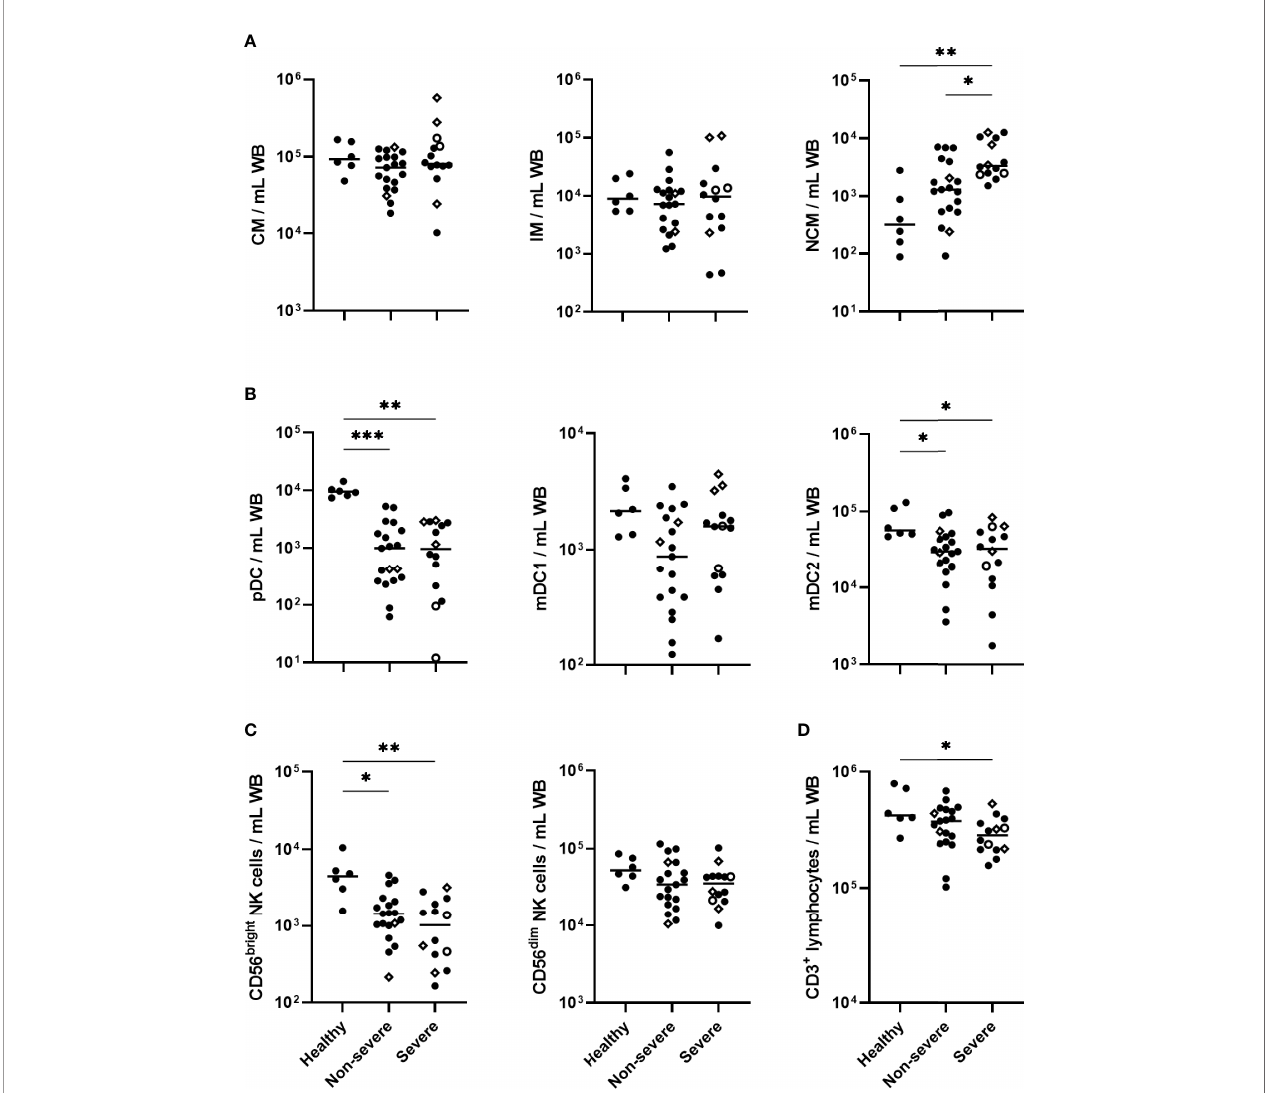
FIGURE 1 | Absolute cell numbers of monocytes, dendritic cell (DC) subsets, NK cell subsets and CD3 + lymphocytes in COVID-19 patients compared to healthy controls. Absolute numbers of (A) classical monocytes (CM), intermediate monocytes (IM) and non-classical monocytes (NCM); (B) plasmacytoid DC (pDC), myeloid DC1 (mDC1) and myeloid DC2 (mDC2); (C) CD56 bright and CD56 dim NK cells (D) CD3 + lymphocytes, are represented for healthy controls (n=6), non-severe (n=19) and severe (n=14) COVID-19 patients at day 0. The patients who died from COVID-19 are represented on the graphs as empty circles, and the patients who declared long-term COVID-19 at their 6 months follow-up (2 out of 8 non-severe and 3 out of 4 severe cases) are represented on the graphs as empty diamonds. The horizontal bars indicate the medians of the results within each column. The signi fi cant p values < 0.05 shown on the graphs were obtained by Kruskal Wallis test, and they are indicated as * p <0.05, ** p <0.01, *** p